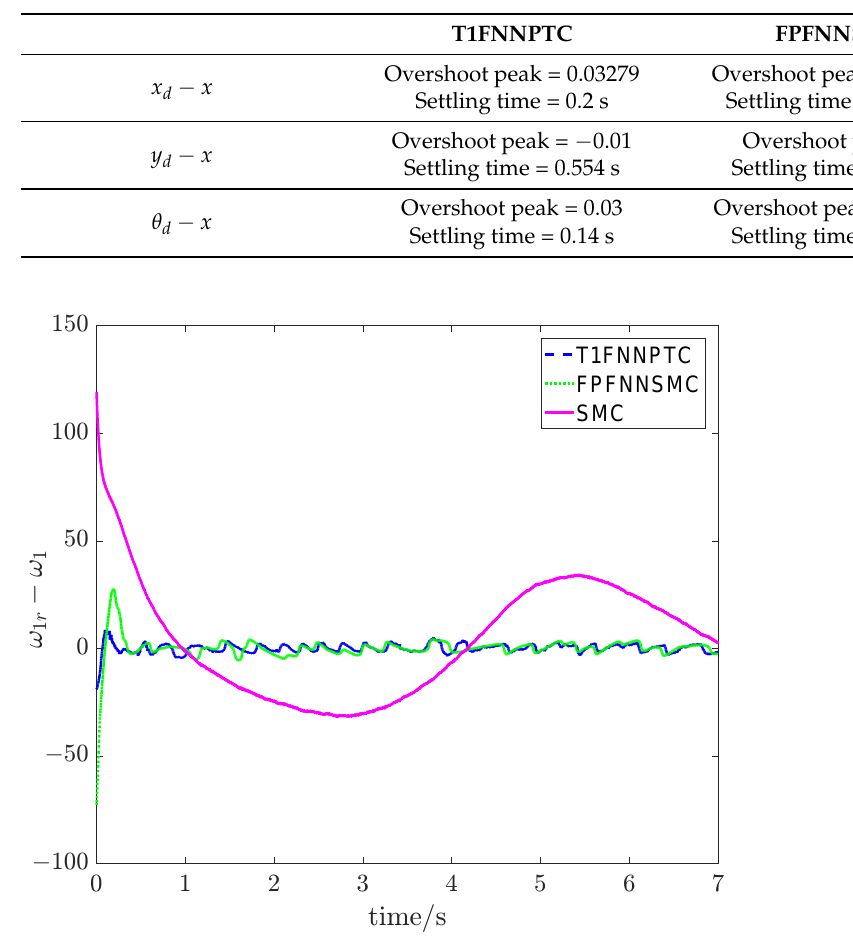
Table 4. Performance parameters.